Question: In one sentence, what is this figure communicating?
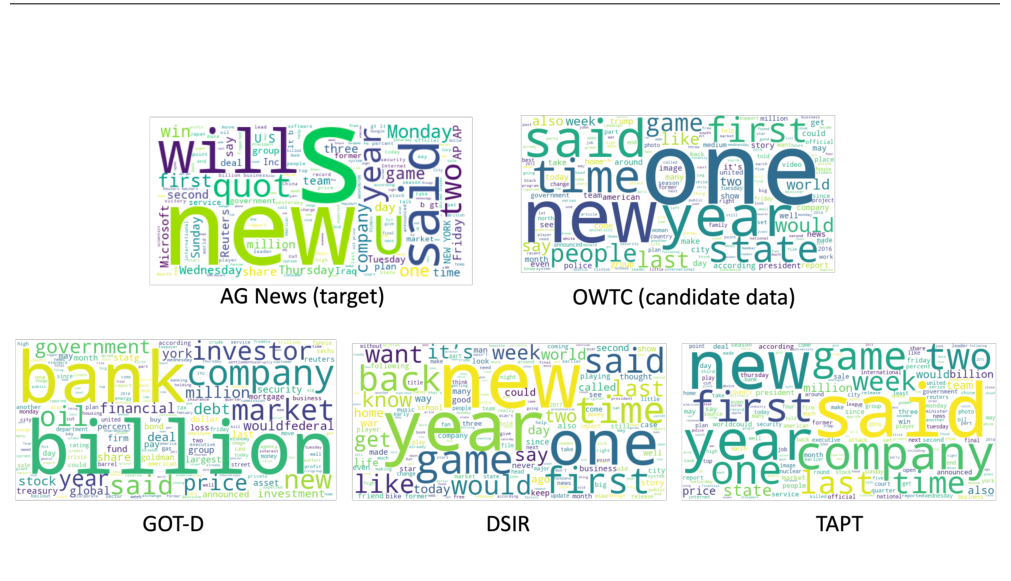
Answer: Word cloud for the first topic in LDA, based on randomly sampled 1000 examples from each dataset. DSIR and TAPT/c select samples that match the distribution of the target task data which has a high overlapping with the distribution of the candidate data where the model is already pre-trained on. In contrast, GOT-D selects predominately formal business news which is highly underrepresented in the candidate dataset but important for the target task. Pre-fine-tuning the model with these samples provides a more direct benefit in aligning the model with the target tasks.